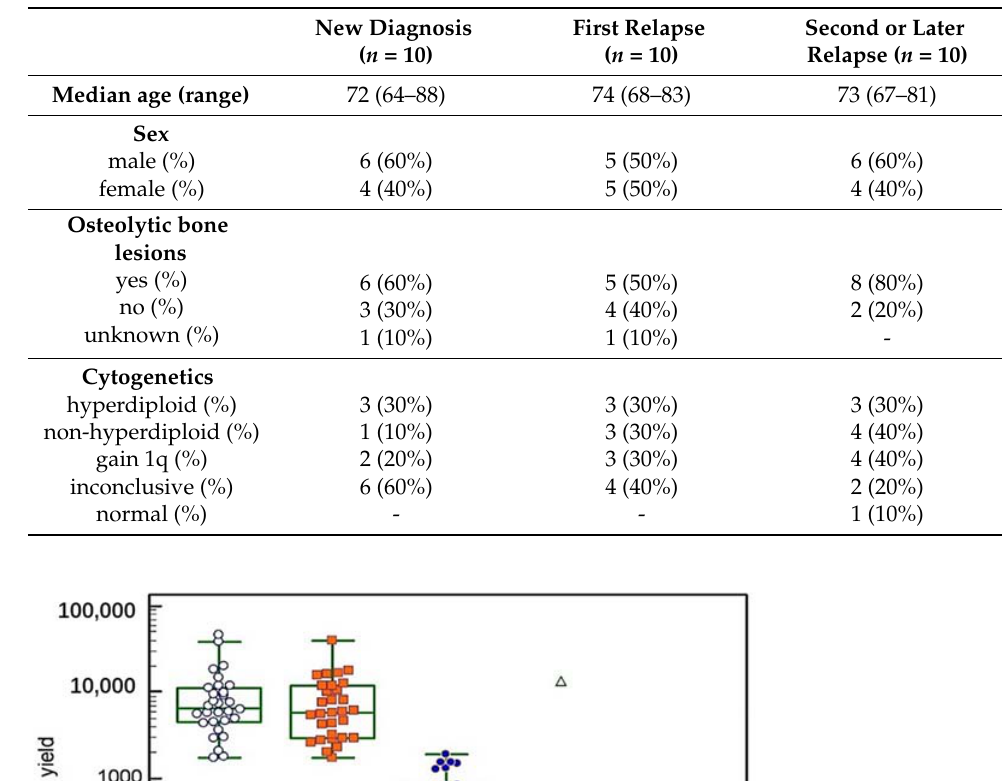
Table 1. Patient characteristics according to disease stage.